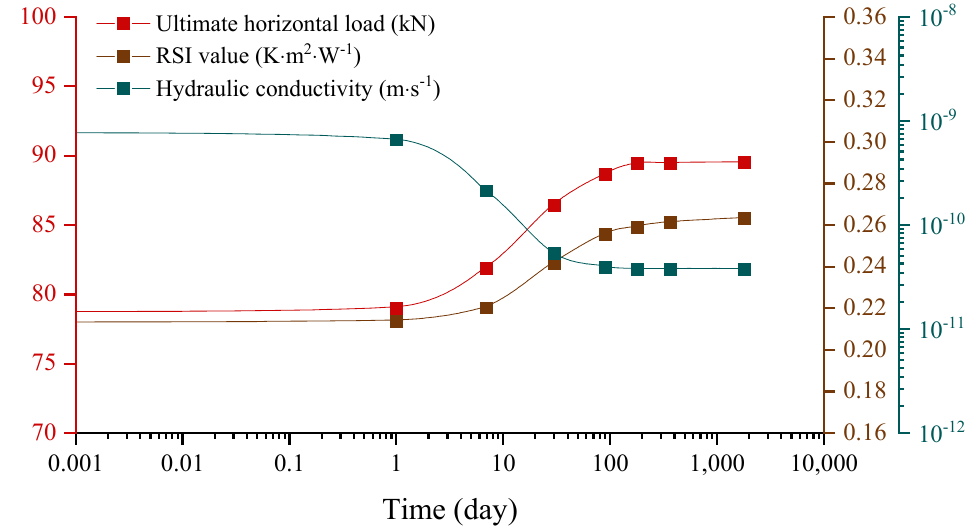
Figure 2. Variations of the ultimate horizontal load, thermal insulation and water permeability of the reference wall within five years.